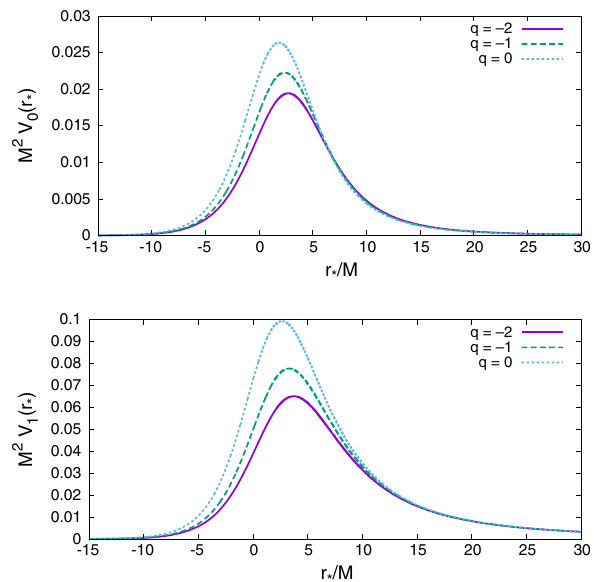
Fig. 3 Effective potential with l = 0 (top) and l = 1 (bottom) in terms of the tortoise coordinate for black holes with q = 0 , − 1 , − 2. The effective potential barrier increases with the increase of l , but its shape remains similar to the case l = 1 (bottom